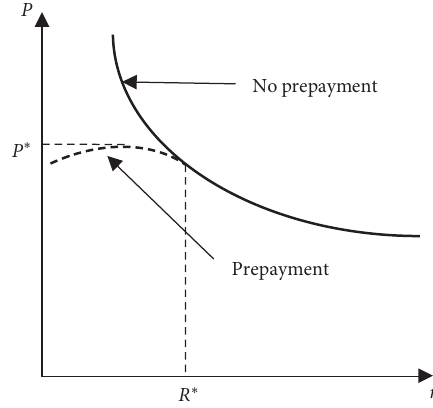
Figure 3: Value-interest rate curve of assets. Figure 4: Value-interest rate curve of